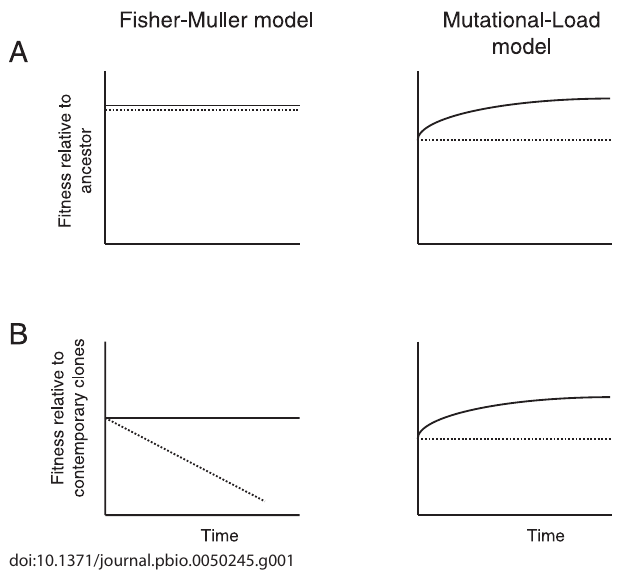
Figure 1. Predictions from the FM and ML Models about the Fitness of a Focal Benefi cial Mutation during Its Increase in Frequency in the